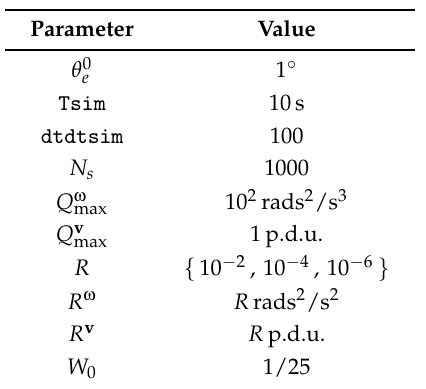
Table 5. Parameters used in the